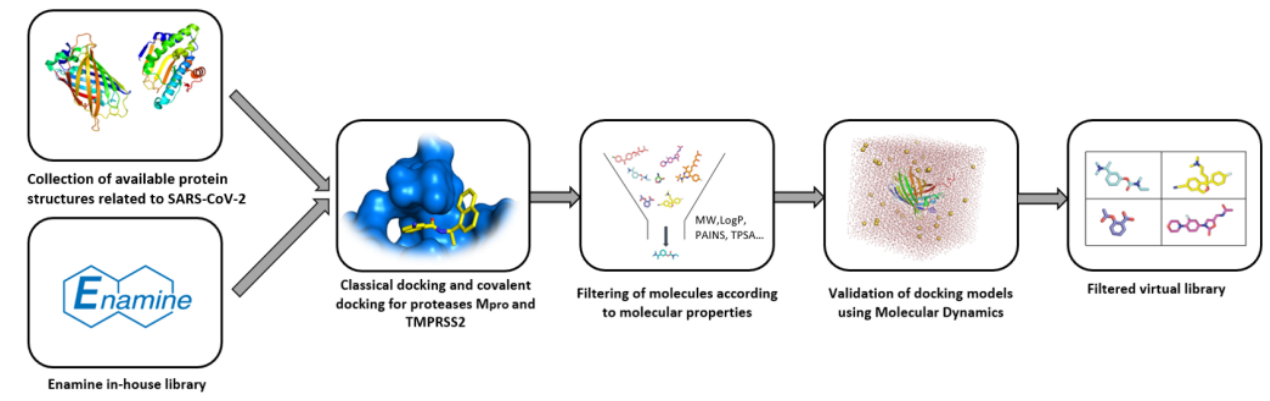
Figure 3. Process algorithm for generating the Enamine SARS-CoV-2-targeted molecular library.